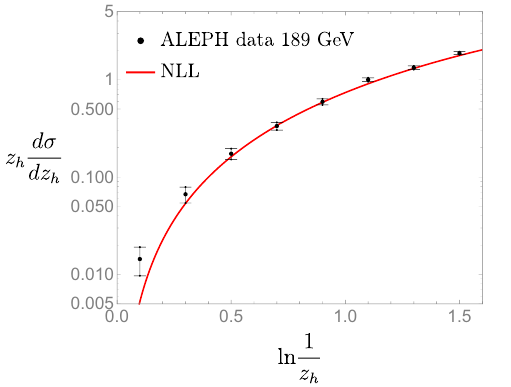
< 0 . 5 was excluded from the fit. z h